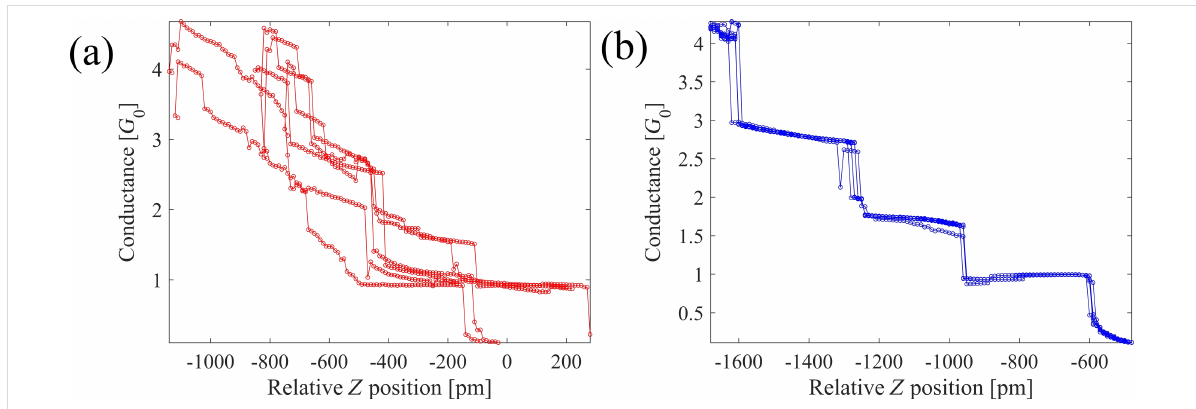
Figure 1: Six consecutive conductance traces of contact breaking showing (a) an initially non-repetitive structure that is converted after mechanical annealing into (b) repetitive conductance traces. The conductance is expressed in units of the quantum of conductance, G 0 = 2 e 2 / h .